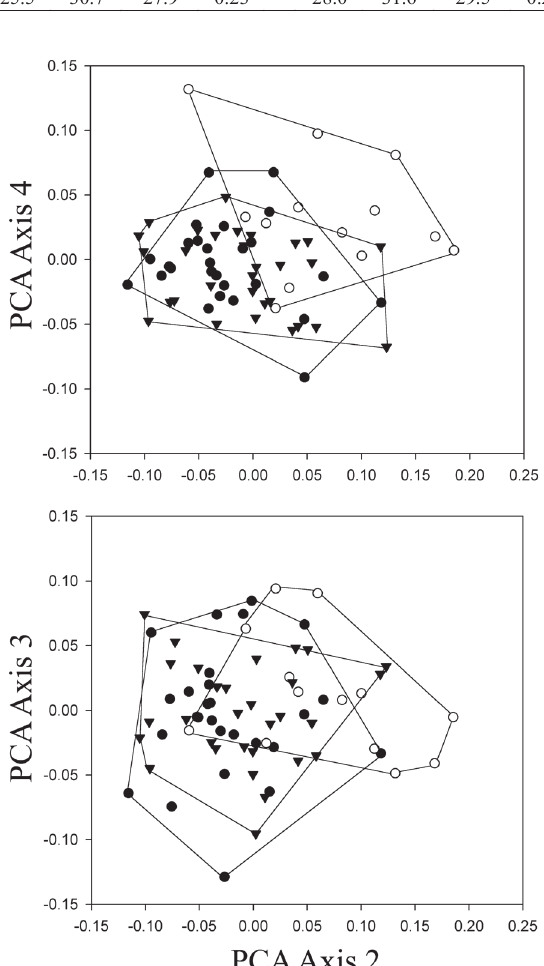
Fig. 1. Plots of factor scores of principal component analysis of three populations of Otocinclus . Dot, Otocinclus arnoldi , río Paraná basin; Circle, paratypes of O . mimulus , upper río Paraná basin; triangle, O . flexilis , laguna dos Patos